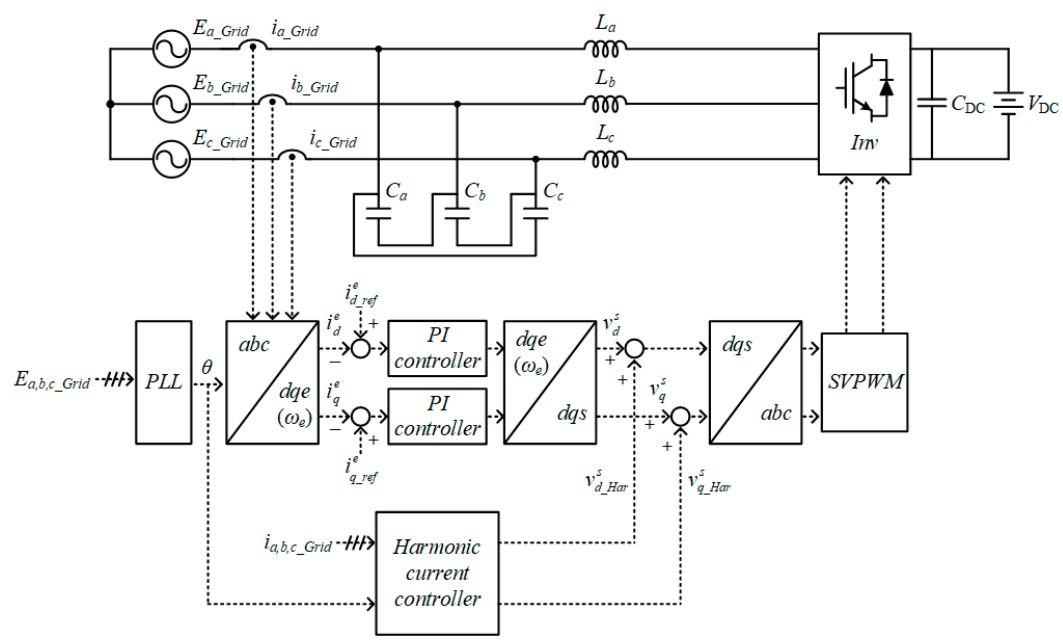
Figure 1. Block diagram of current control strategy with harmonic compensation method. PI: proportional integral. PLL: phase locked loop. SVPWM: space vector pulse width